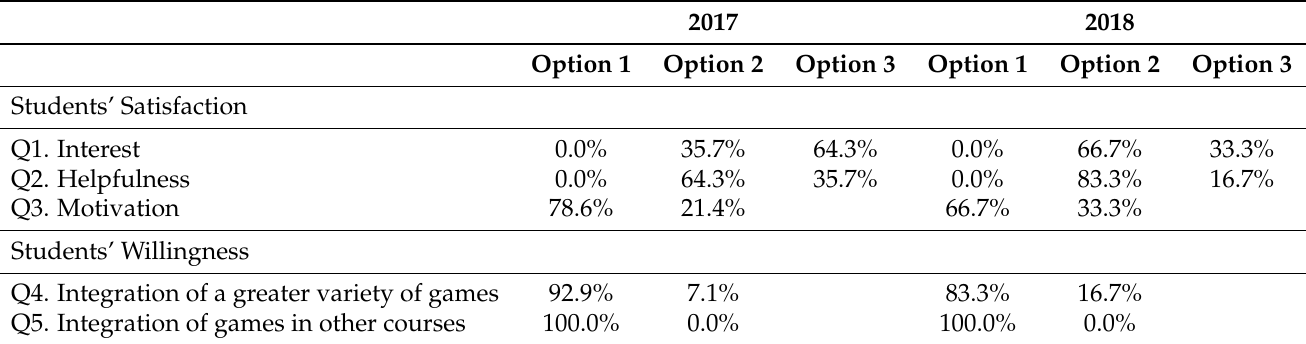
Table 2. Evaluation of students’ satisfaction and